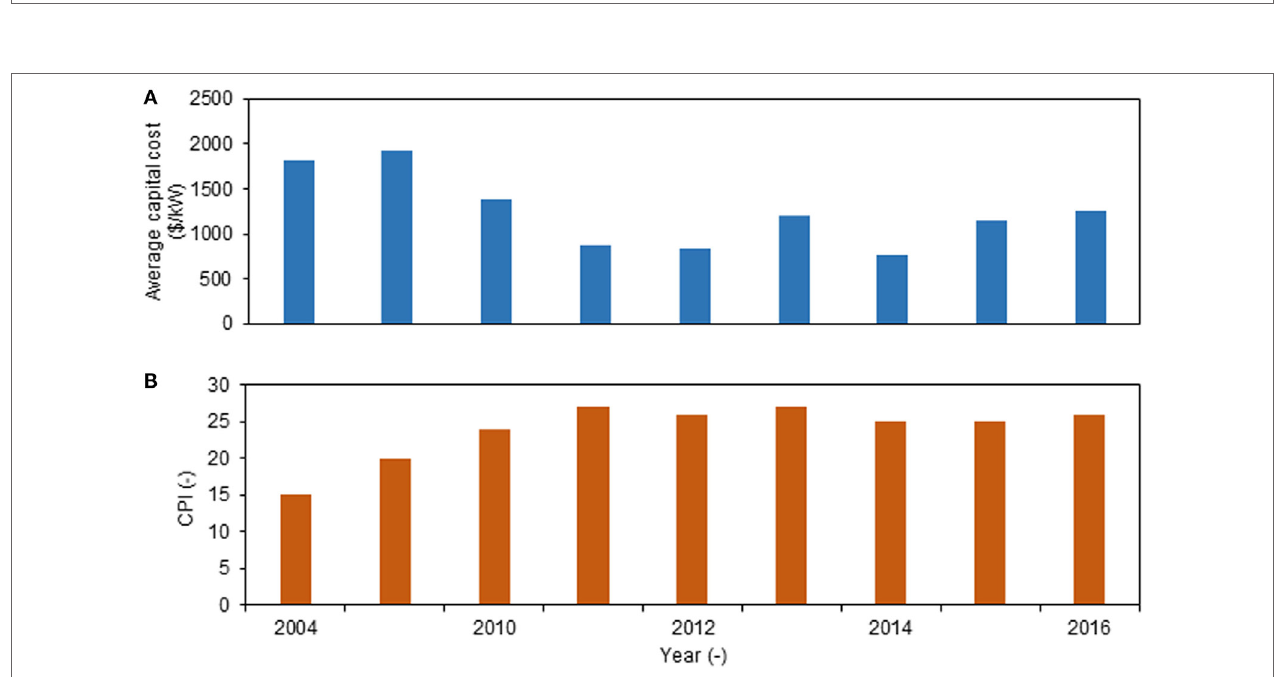
FigUre 6 | (a) Average capital cost (2004–2016) and (B) Corruption Perceptions Index (CPI) score (2004–2016). Chart (B) is demonstrating that CPI is not gradually reducing. Moreover, the average capital cost of power plants is related to the change of CPI score. Here, higher CPI score means lower